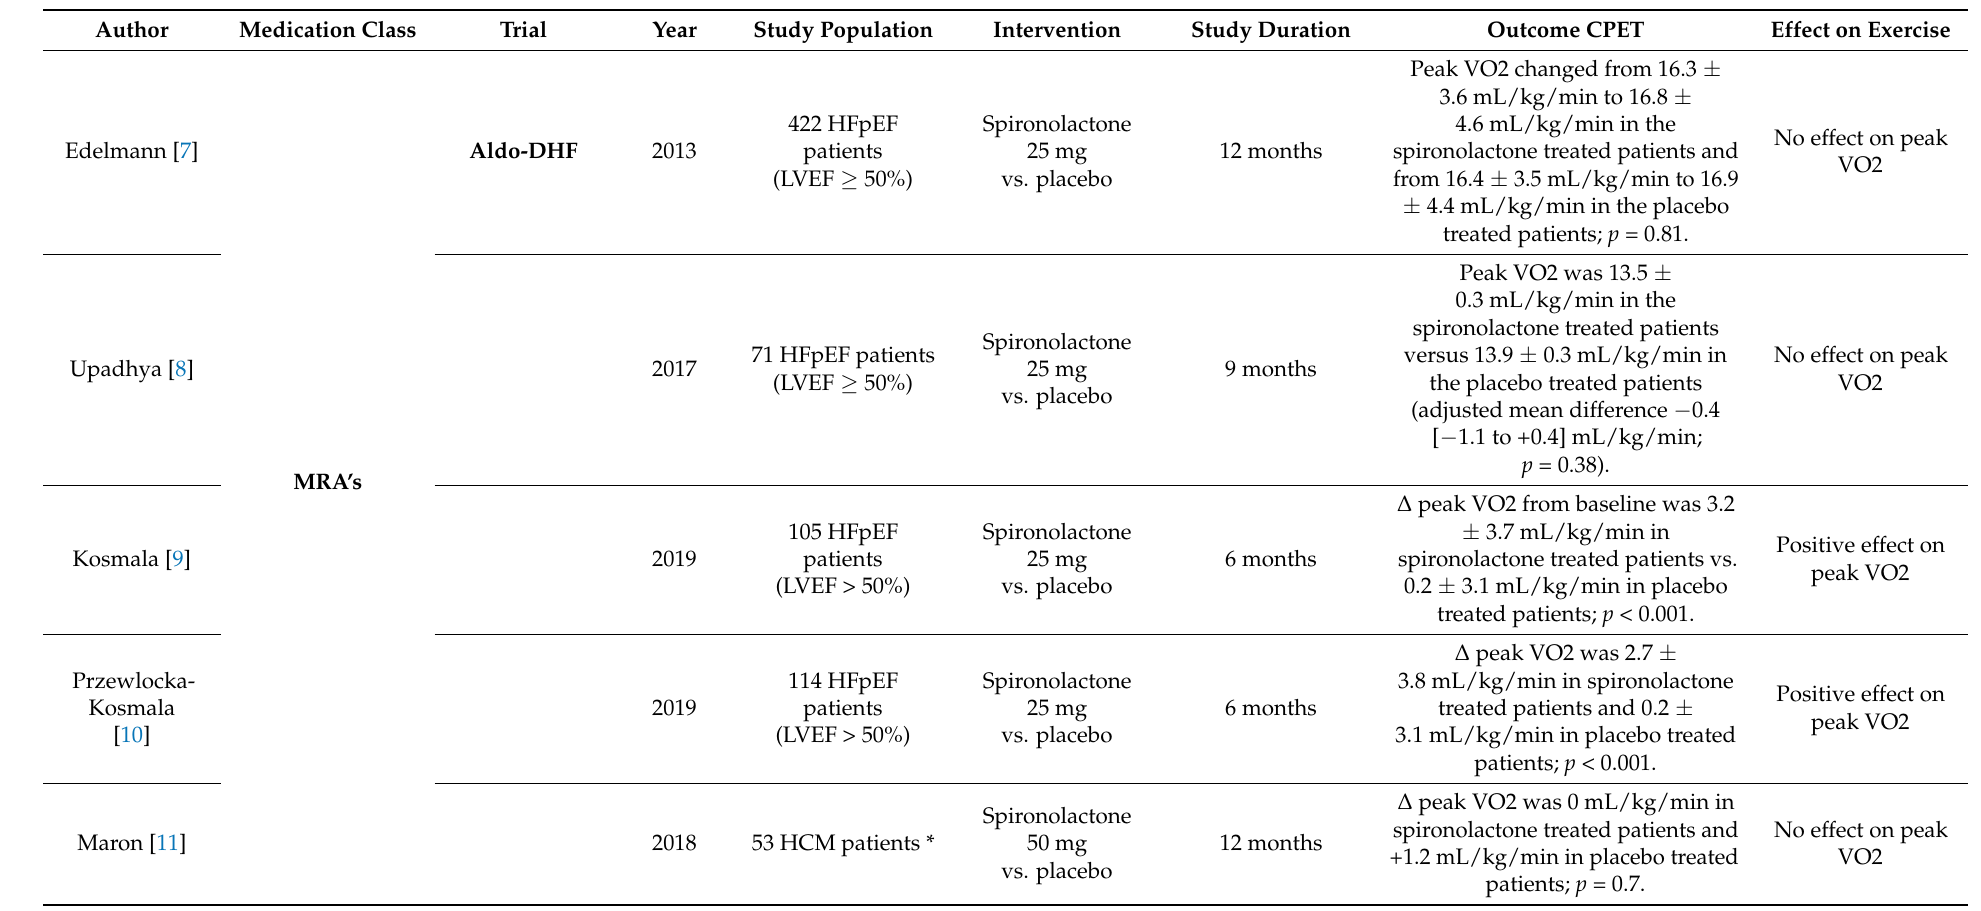
Table 1. Overview of clinical studies on the effect of guideline-recommended heart failure medical therapy on exercise performance in